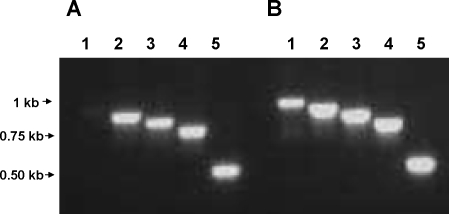
Start site for pilus gene transcription in the rofA::aad9 construct.cDNA generated from RNA derived from wt Alab49 (A) or Alab49 rofA::aad9 (B) was used as a template for PCR amplification; amplicons were subject to agarose gel electrophoresis and ethidium bromide staining. All reactions are paired with reverse primer CPA-R in combination with UP-F1 (lane 1), UP-F2 (lane 2), UP-F3 (lane 3), UP-F4 (lane 4) and CPA-F (lane 5). Positions for primers UP-F1 through F4 are also depicted in Figure 1C. Molecular size markers are indicated.